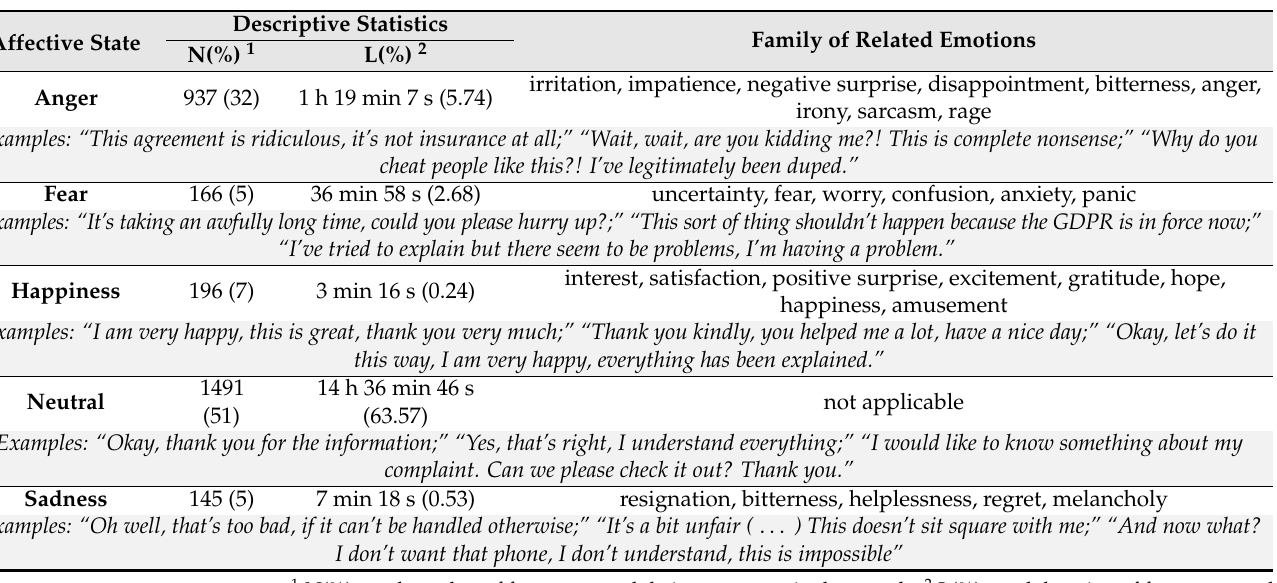
Table 2. Frequency analysis of the emotional coloring of utterance fragments in Sample 1 (voice